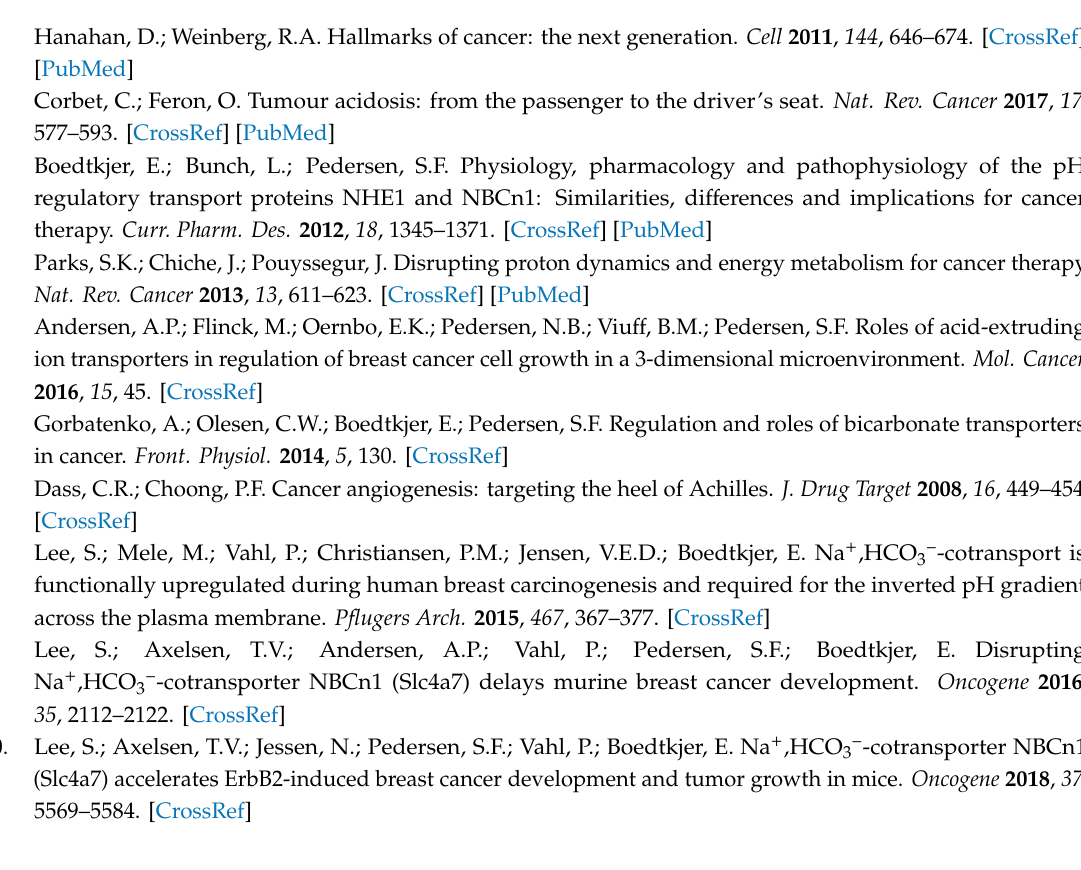
Figure S1–S3: Illustrated results of Ingenuity Pathway Analyses, Figure S4: Full uncropped images of immunoblots from Figure 5, Table S1: Mass spectrometry